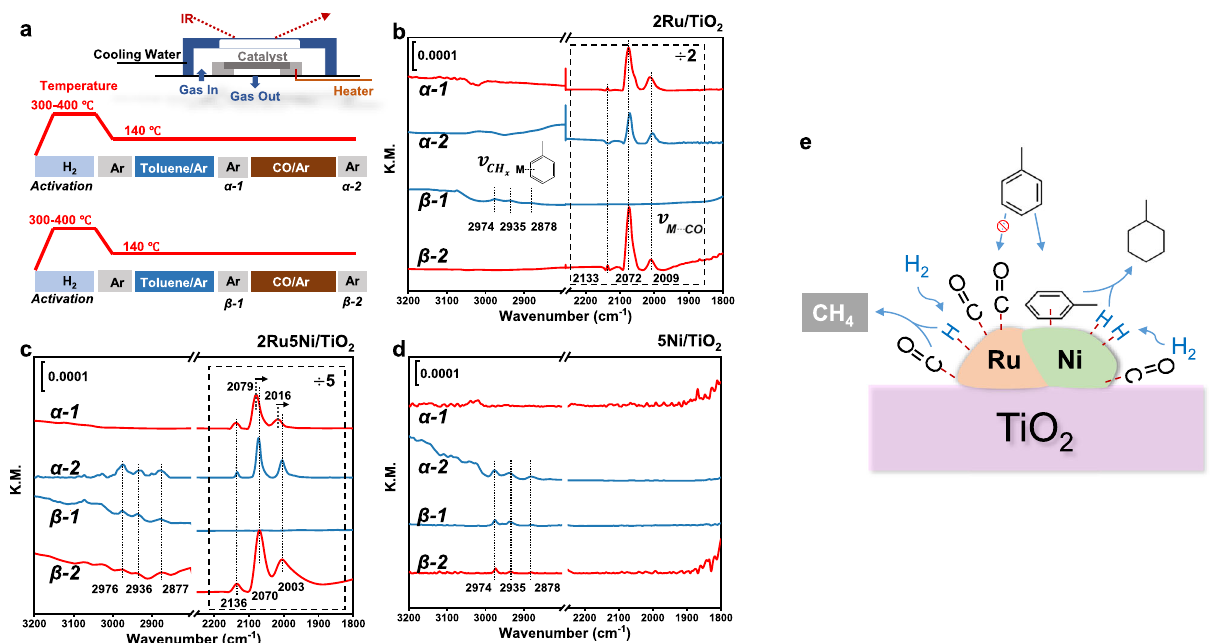
Fig. 4 | Mechanism studying by in situ DRIFT spectroscopy. a Diagram of the operationsincludingthepre-reductionandswitchingdetails,where α -1, α -2, β -1,and β -2 present the spectra collected in different conditions. α -1 was recorded after CO (CO:Ar=5:95, v/v) adsorption and Ar sweeping; then followed α -2 recorded for toluene (toluene: Ar=3:97, v/v) adsorption after CO treatment. After re fi lling the catalyst, the same process was carried out except toluene adsorption ( β -1) was